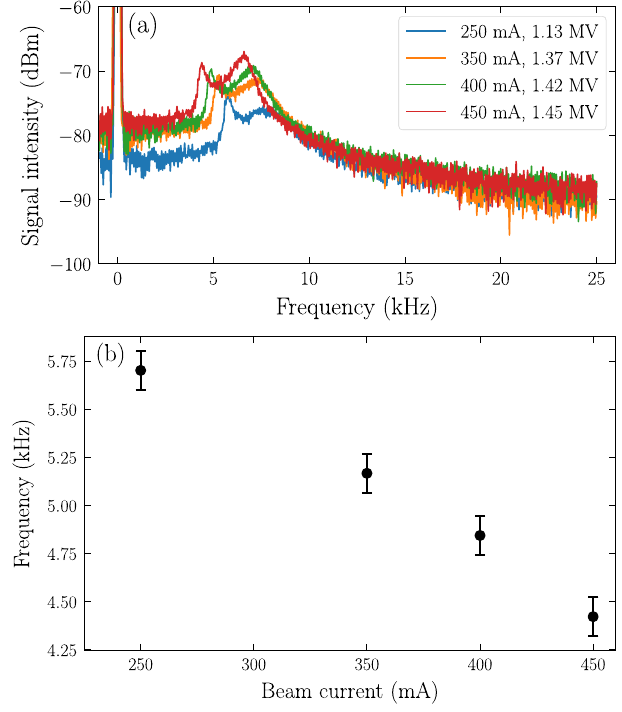
FIG. 15. (a) Beam responses measured under different sets of beam current and cavity voltage and (b) frequency of the unexpected peak as a function of the beam currents. The fill pattern was four trains of 47 bunches. The error bars were determined by convoluting the fitting error and the resolution bandwidth of the spectrum